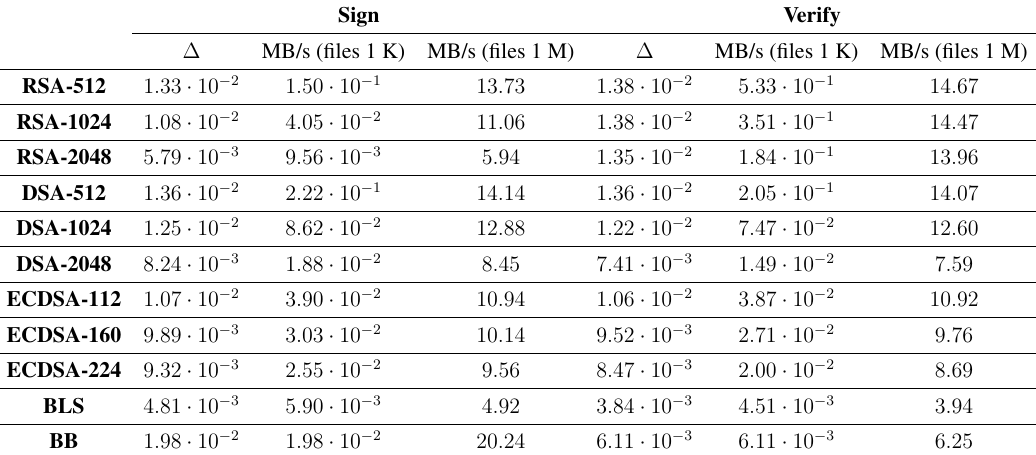
Table 6. Digital Signature Performance (MB/s) in